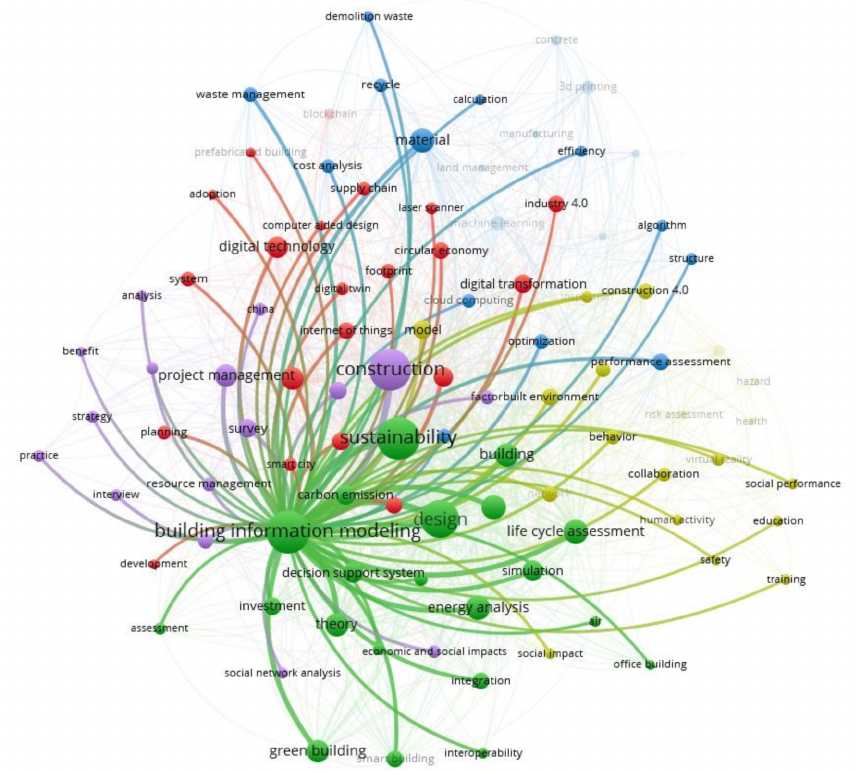
Figure 8. The keyword network of building information